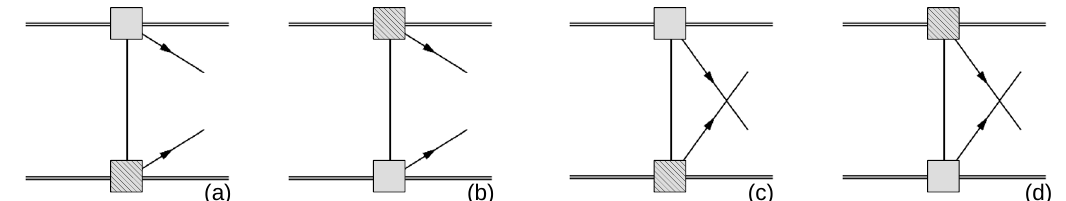
Figure 2 . Tree-level contributions to the 0 (cid:23)(cid:12)(cid:12) transition operator arising from the exchange of a light neutrino. The notation for nucleons, electrons, and neutrinos is as in (cid:12)gure 1. The squares denote the nucleon vector, axial, scalar, pseudoscalar, and tensor form factors, which, at LO in chiral EFT, include one or both diagrams in (cid:12)gure 1. The currents acting on the two nucleons can be di(cid:11)erent, which we denoted by hatching one of the two squares. LNV arises from the mass of the neutrinos, which in general are Majorana eigenstates, or from the couplings of the neutrinos to the nucleons, which receive LNV contributions at